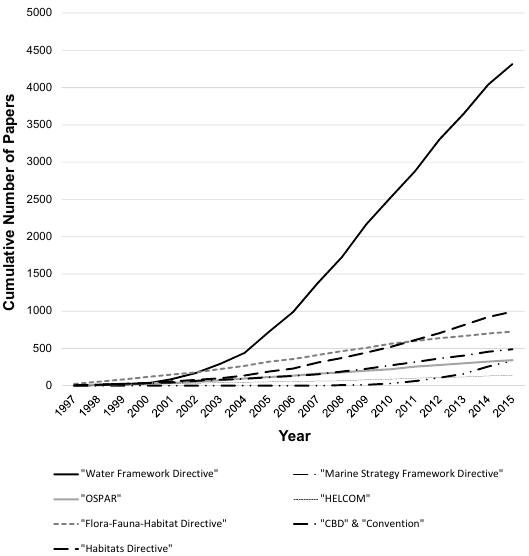
Figure 1. Comparison of the cumulative number of scientific publications referring to the Water Framework Directive (title, keywords, abstract) and other EU Directives, International Conventions on the Protection of the Marine Environment for the North Sea (OSPAR) and the Baltic Sea (HELCOM), the Habitats Directive, and the Convention on Biological Diversity (CBD) (Source: www.scopus.com, queried in December 2015).